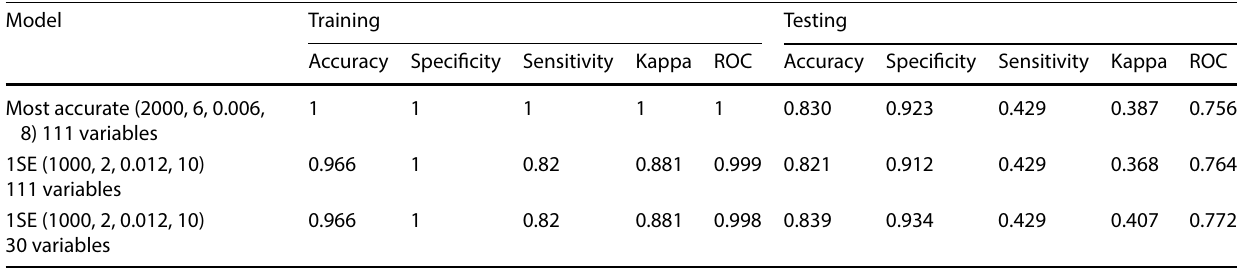
Table 2 Model evaluation results for the boosted regression trees models